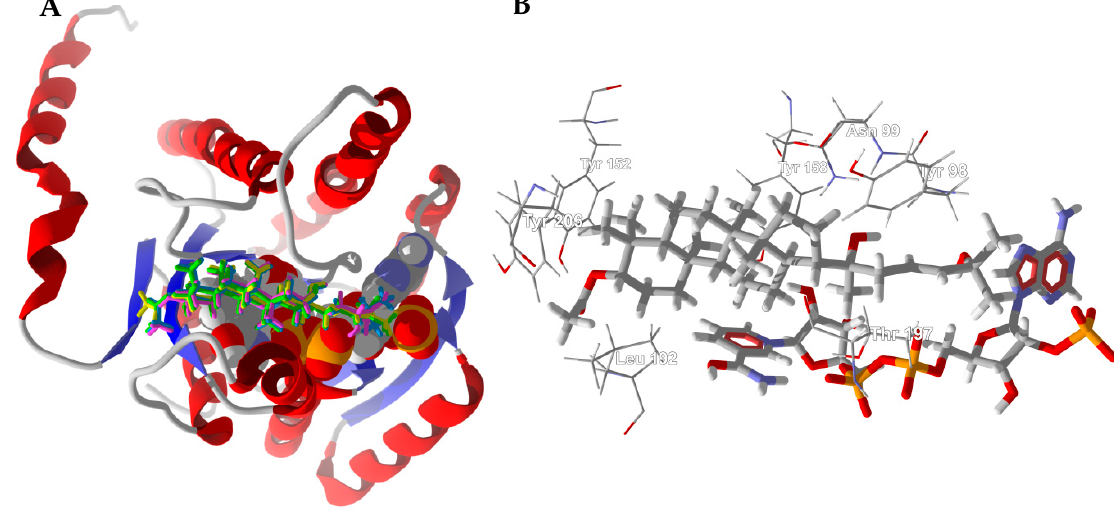
Figure 13. Guinea pig 11 β -hydroxysteroid dehydrogenase type 1 (Cp11 β -HSD, PDB 3lz6). ( A ): Lowest-energy docked poses of 3 β -acetoxy-20 S ,24 R -dihydroxydammar-25-ene (magenta), 3 β - acetoxydammar-24-ene-16 β ,20 R -diol (green), dammarenediol II acetate (yellow), and isofouquieryl acetate (blue) with Cp11 β -HSD. The NADPH cofactor is shown as a space-filling model. ( B ): Isofouqueryl acetate in the active site of Cp11 β -HSD showing the molecular environment.